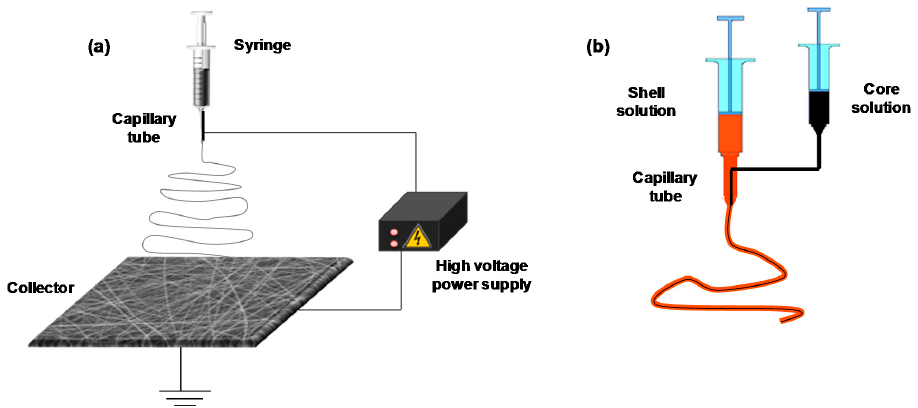
Figure 1. Electrospinning setup for the preparation of uniaxial fibers ( a ), and configuration of syringes and capillaries for preparation coaxial fibers ( b ). and capillaries for preparation coaxial fibers ( b